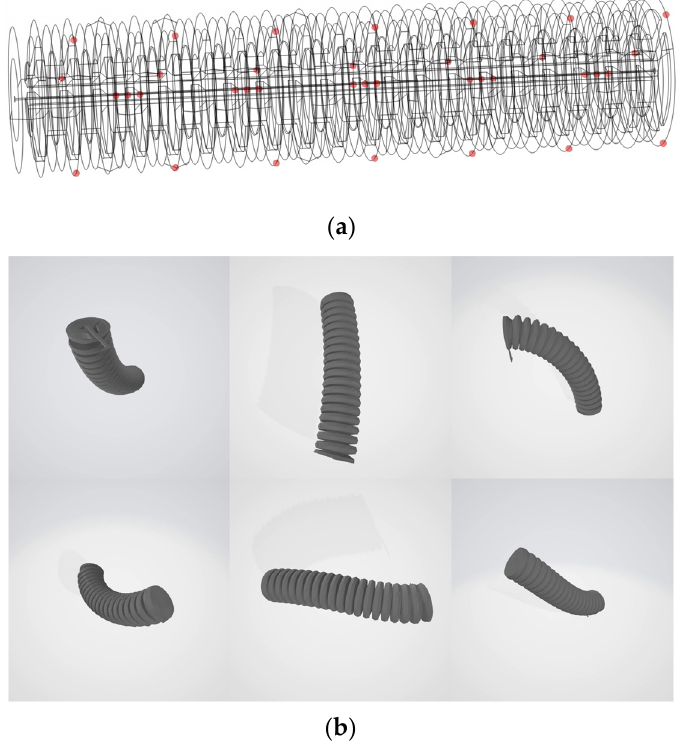
Figure 5. ( a ) The points used to describe the axis curvature and the outside posture. ( b ) The simula- tion results of the actuator deformation using the Ansys fl uid–solid coupling simulation